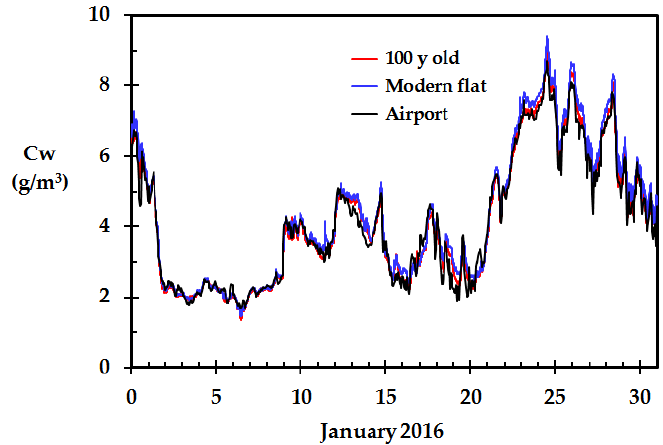
Figure 5. Calculated outdoor water vapor concentration for the recordings outside the 100 years old home, the modern flat and the local meteorological station (Haugesund airport), January 2016.